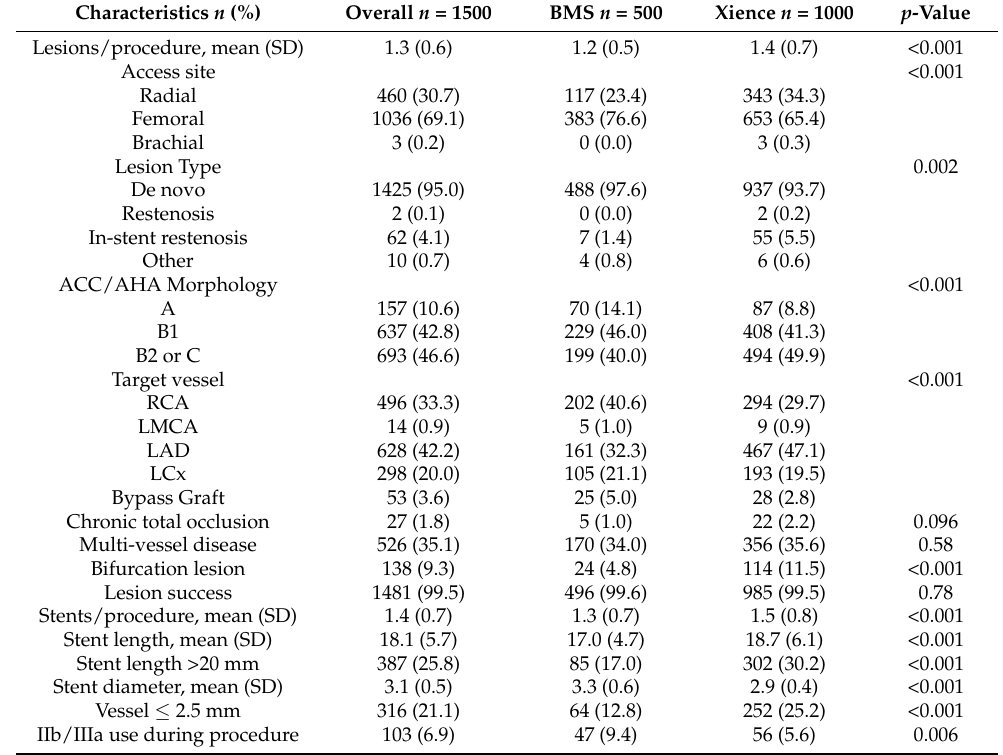
Table 2. Lesion & Procedural